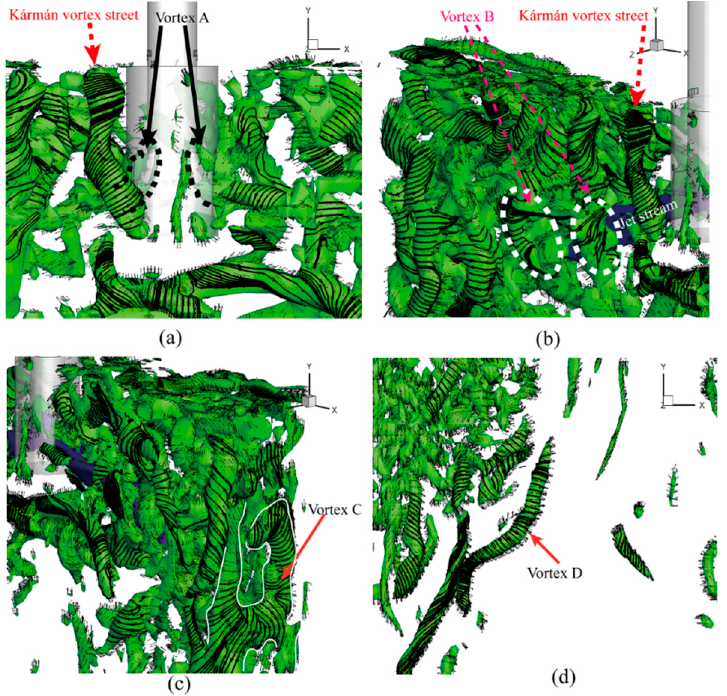
Figure 10. Typical shapes of the vortex, vector and streamline in the vortex surface at different positions in the mold (solution time at 40 s, under the non-clog case), ( a ) the nozzle port of the SEN, ( b ) the outer side of the jet-stream, ( c ) the narrow side of the mold, ( d ) the lower part of the mold center.